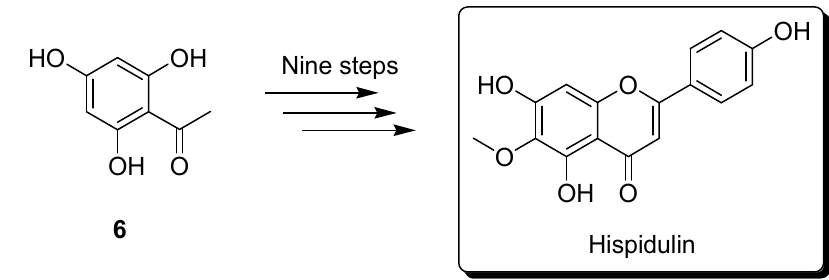
Scheme 2. Synthesis of hispidulin by Kavvadias and coworkers.